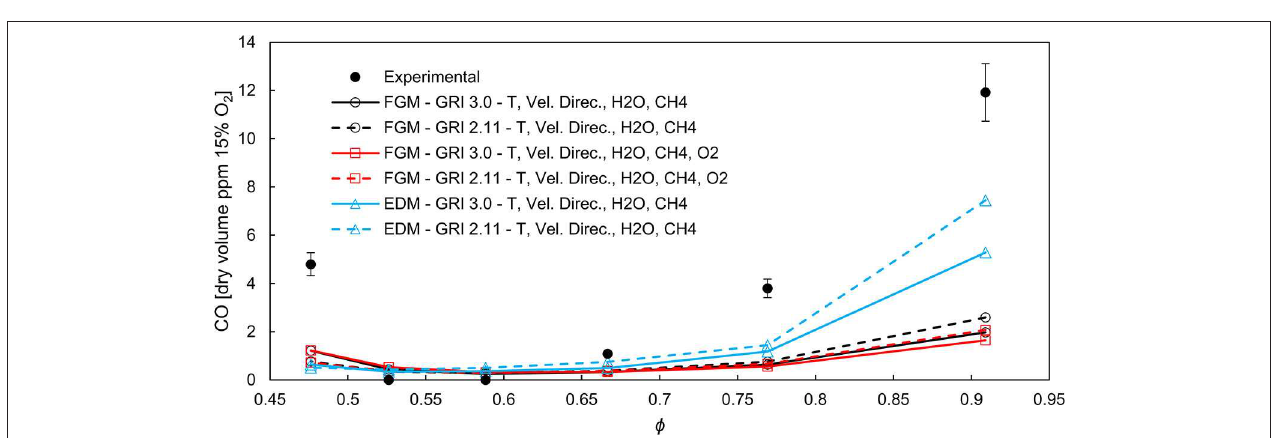
FIGURE 10 | Outlet CO results from AGNES compared with experimental results. Different input simulations for AGNES (FGM or EDM) and post-processing options (GRI 3.0 or GRI 2.11, as well as clustering criteria).